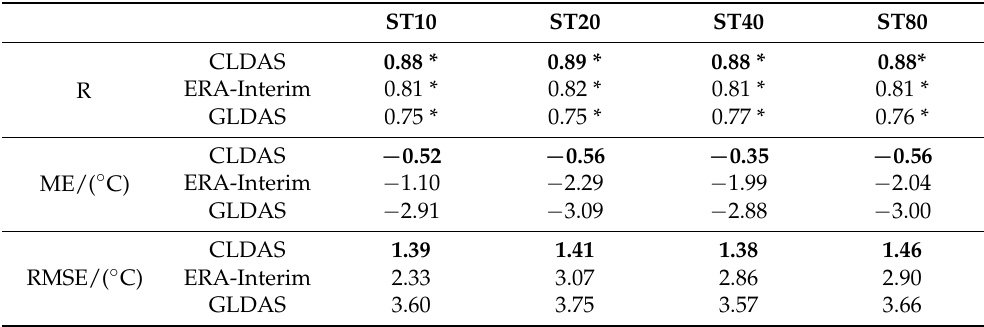
Table 2. Correlation coefficient (R), mean error (ME), and root-mean-square error (RMSE) of soil temperature.